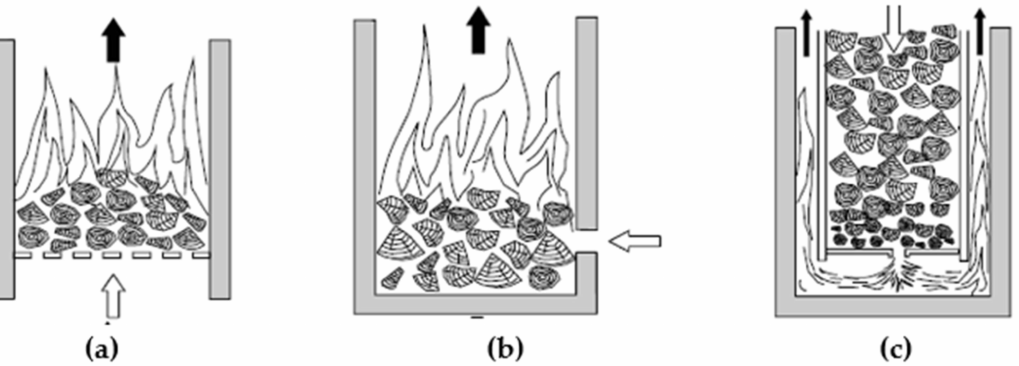
Figure 9. Schemes of combustion principles regarding primary air supply (white arrow) and flue gas pathways (black arrow) [37]. Reprint with permission from Gaderer, M. et al. (2016). Direkte thermo-chemische Umwandlung (Verbrennung). In: Kaltschmitt, M., Hartmann, H., Hofbauer, H. (eds) Energie aus Biomasse; Copyright 2016, Springer Vieweg, Berlin, Heidelberg. Burn-through combustion principle ( a ); Top-down combustion principle ( b ); Bottom-up or downdraft combustion principle ( c